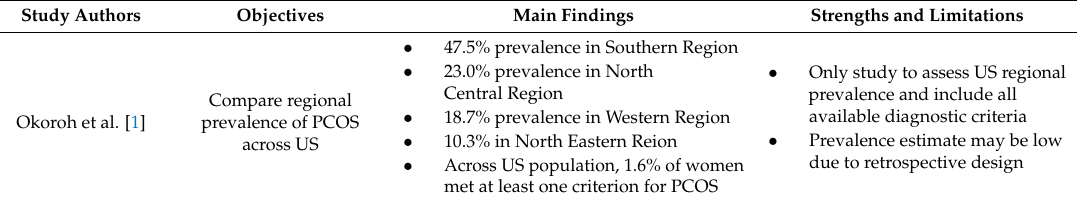
Table 2. Summary of studies on PCOS prevalence in the United